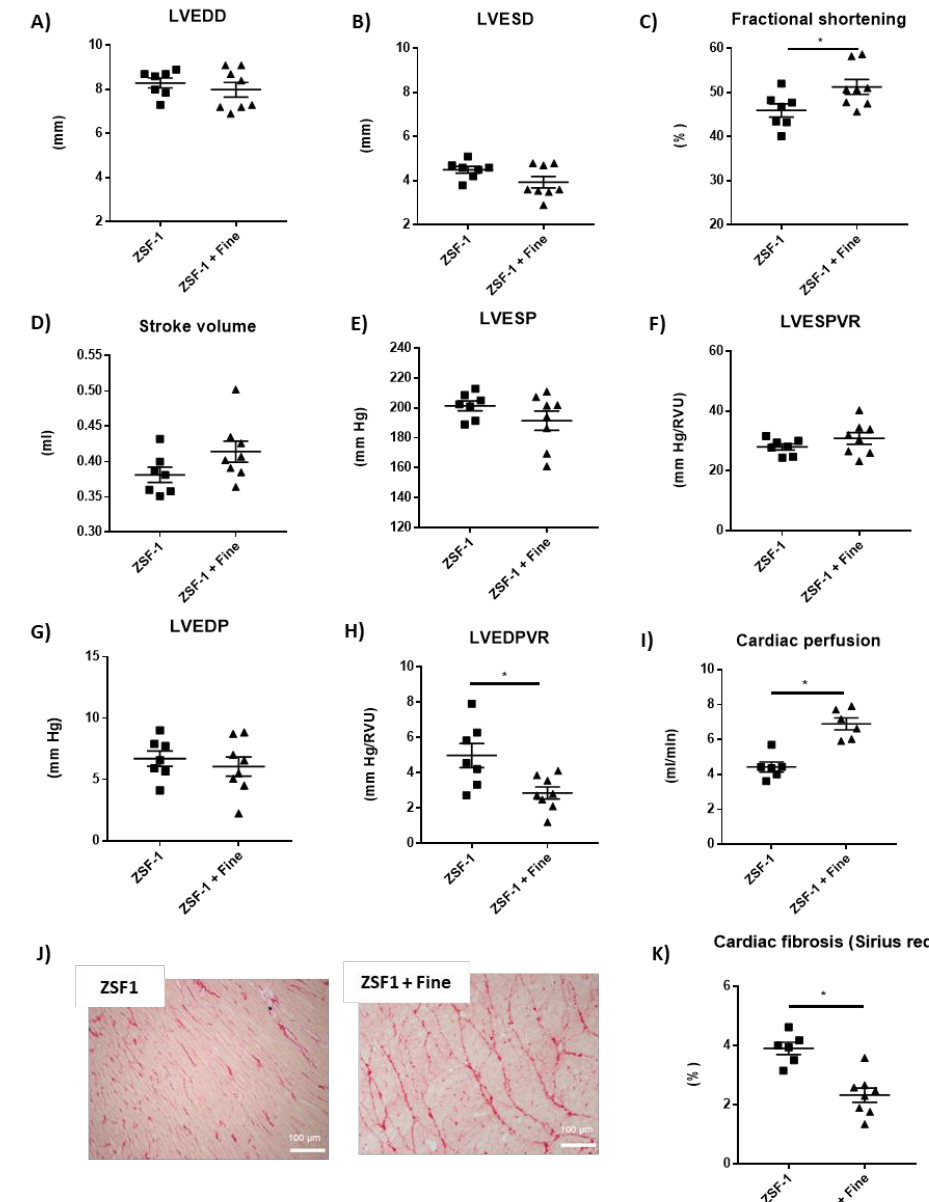
Figure 4. Finerenone ameliorates diastolic dysfunction and fibrosis together with better myocardial perfusion. Left ventricle end-diastolic diameter ( A ), left ventricle end-systolic diameter ( B ), fractional shortening ( C ), stroke volume ( D ), left ventricle end-systolic pressure ( E ), left ventricle end-systolic pressure – volume relationship ( F ), left ventricle end-diastolic pressure ( G ), left ventricle end-diastolic pressure – volume relationship ( H ) and left ventricle tissue perfusion ( I ). Representative light microphotographs (20× magnification) of rat kidney sections stained with Sirius red ( J ) and kidney fibrosis quantification ( K ). Student’s t -test was used for statical analysis, n = 5 −8 . * p < 0.05 vs. ZSF-1.